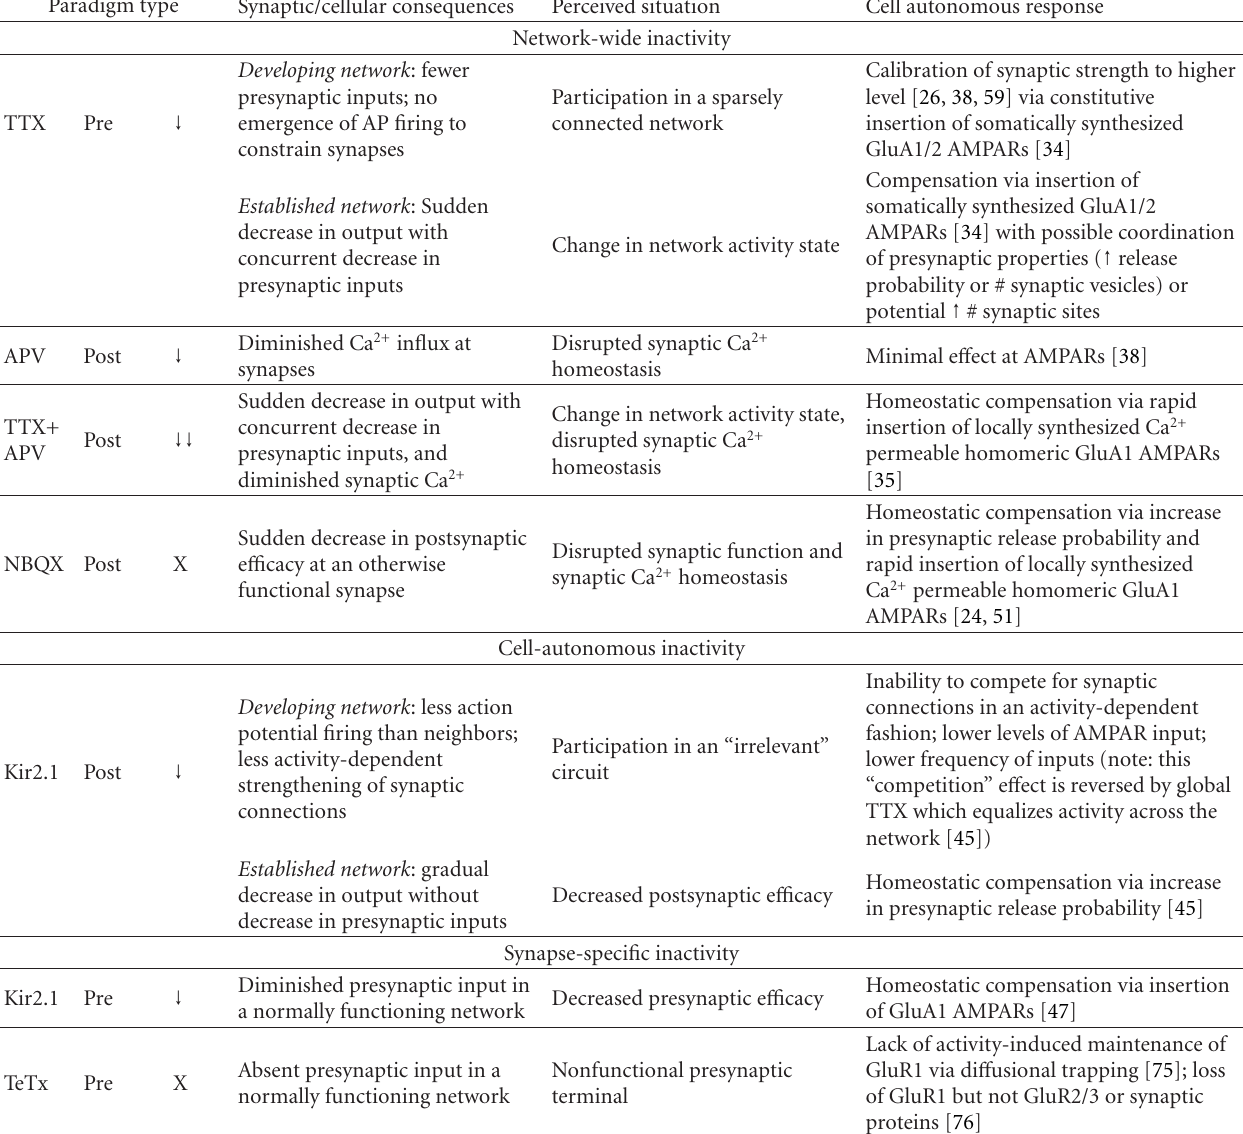
Table 2: Inactivity paradigms: consequences and responses. Inactivity paradigms are grouped by scope: network-wide, cell autonomous, or synapse specific. Each inactivity paradigm is evaluated based on its type: presynaptic (Pre) or postsynaptic (Post) mode of action, and reduction ( ↓ ) or elimination (X) of